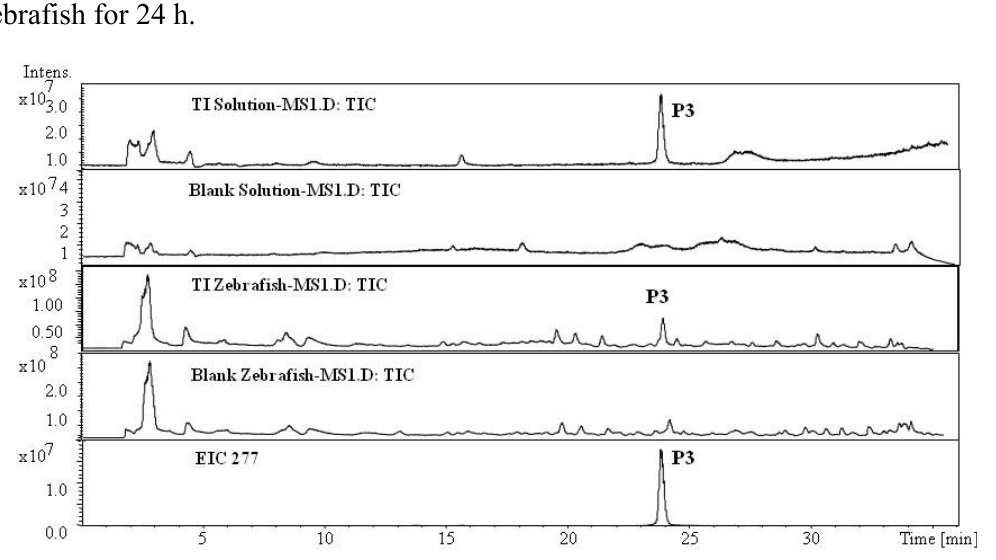
Figure 4. Total ion chromatogram and extracted ion chromatograms for TI after exposure to zebrafish for 24